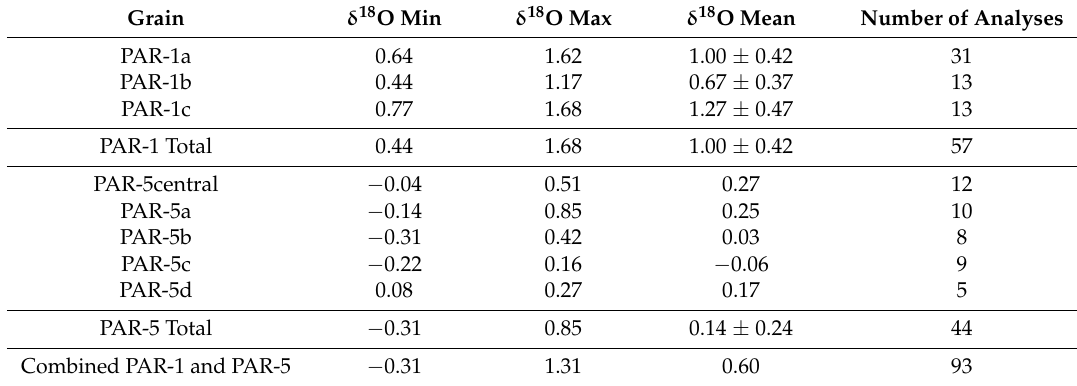
Table 2. Oxygen isotope results from 2017 using the SIMS method.